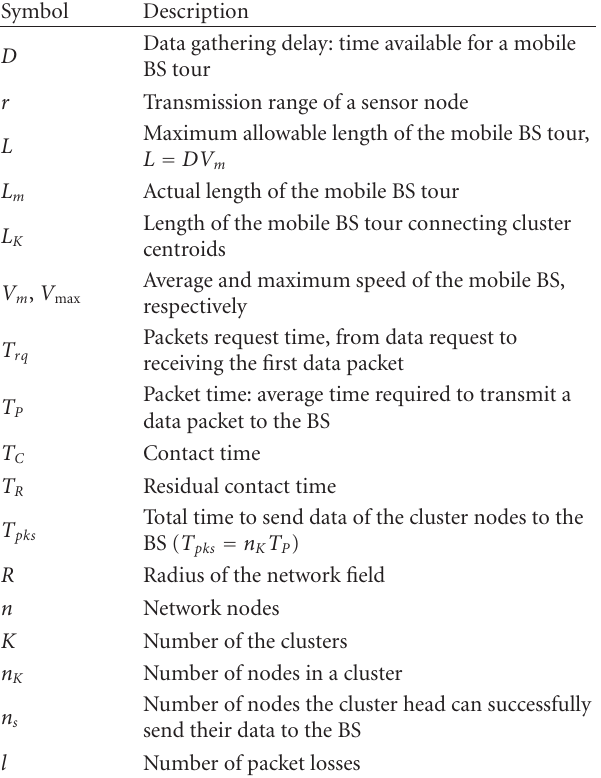
Table 1: Definitions of the main symbols used throughout the paper.